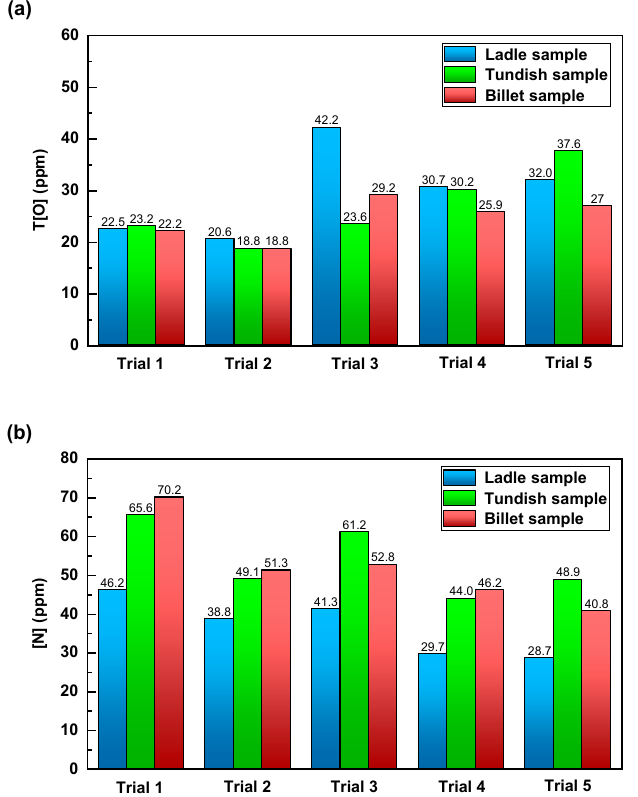
Figure 18. Variations of ( a ) total O content and ( b ) N content in steel samples taken from ladle, tundish, and casting billet for the five industrial trials.